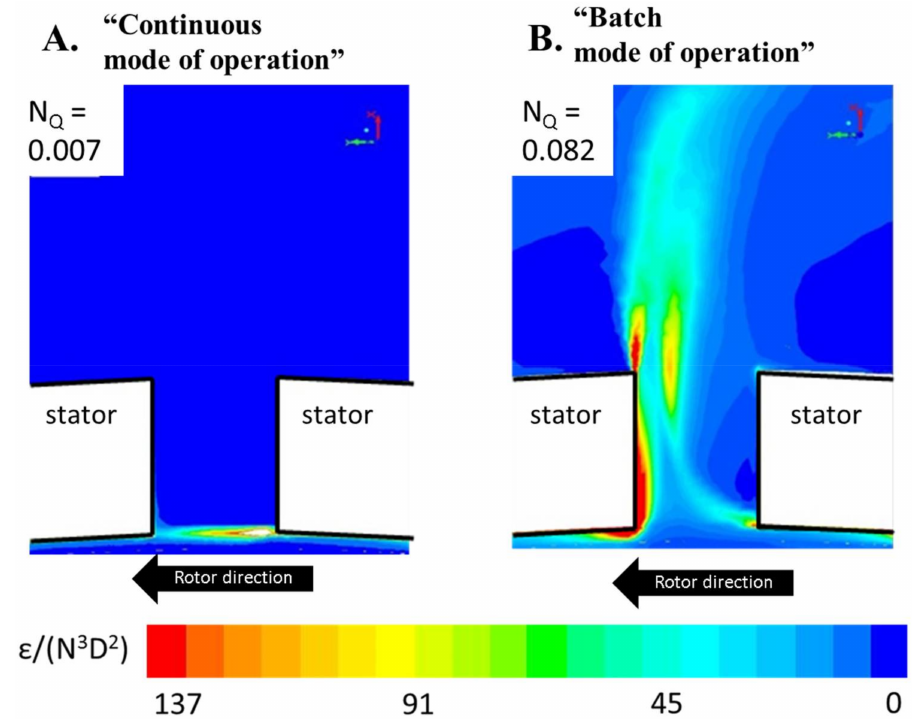
Figure 6. CFD-estimated dissipation rates of turbulent kinetic energy TKE in the stator slot region for the same rotor-stator head run at a flow number corresponding to an RSM run under continuous mode of operation ( A ) and run under batch mode of operation ( B ). Adapted from data obtained in Reference